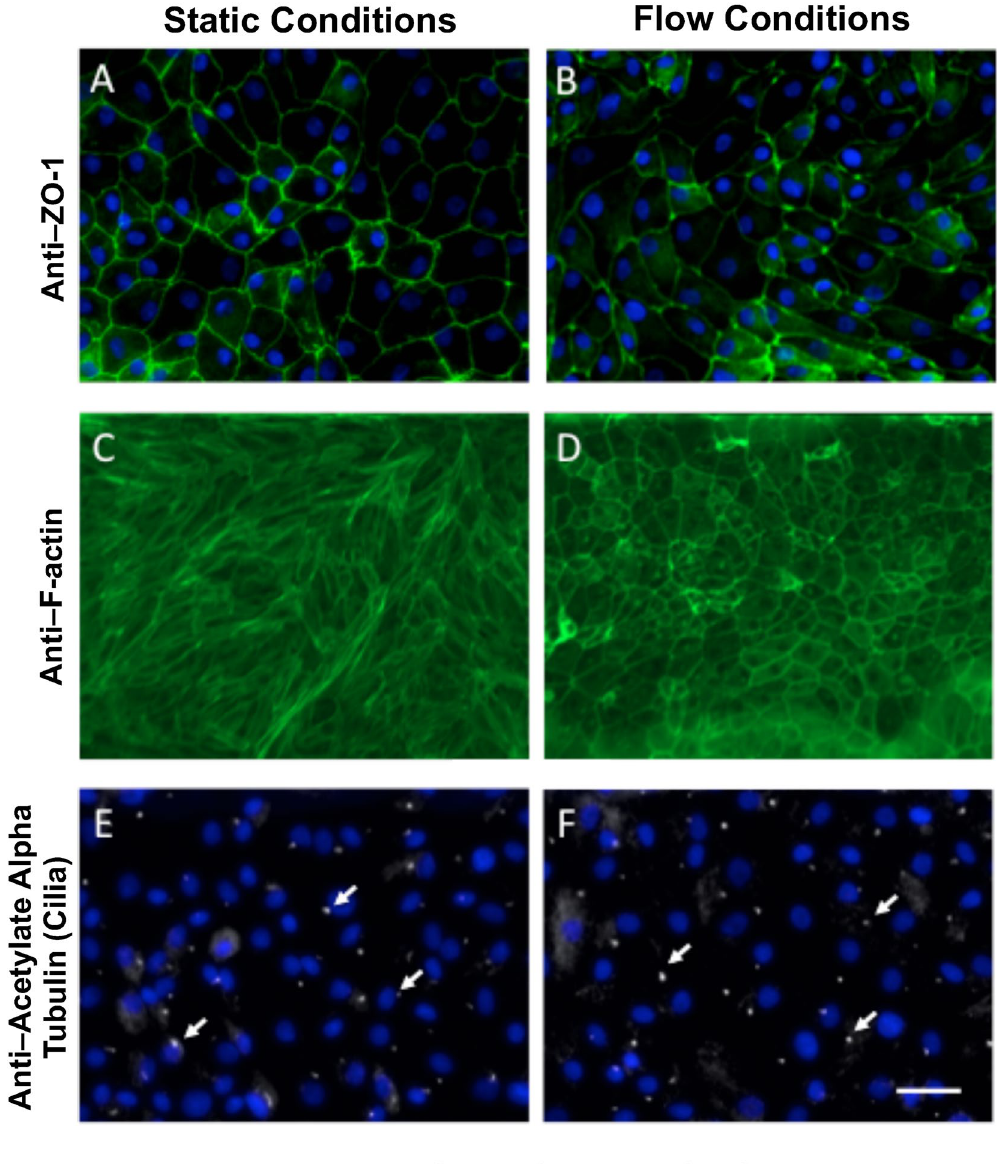
Figure 5. Human kidney proximal tubular epithelial cell morphology 24 h under static conditions versus fluid shear stress. Immunofluorescence staining of the tight junction protein ZO-1 (tight junctions) (green) and DAPI (blue) in static ( A ) and flow cells ( B ). Immunofluorescence images of F-actin under static conditions ( C ) and after 24 h of exposure to fluid shear stress ( D ). Under the shear stress, F-actin reorganizes at the periphery of the cells ( D ). Immunofluorescence staining of acetylated tubulin (white) to visualize primary cilia and DAPI (blue) under static ( E ) and flow ( F ) remain similar under both conditions. (Bar = 50